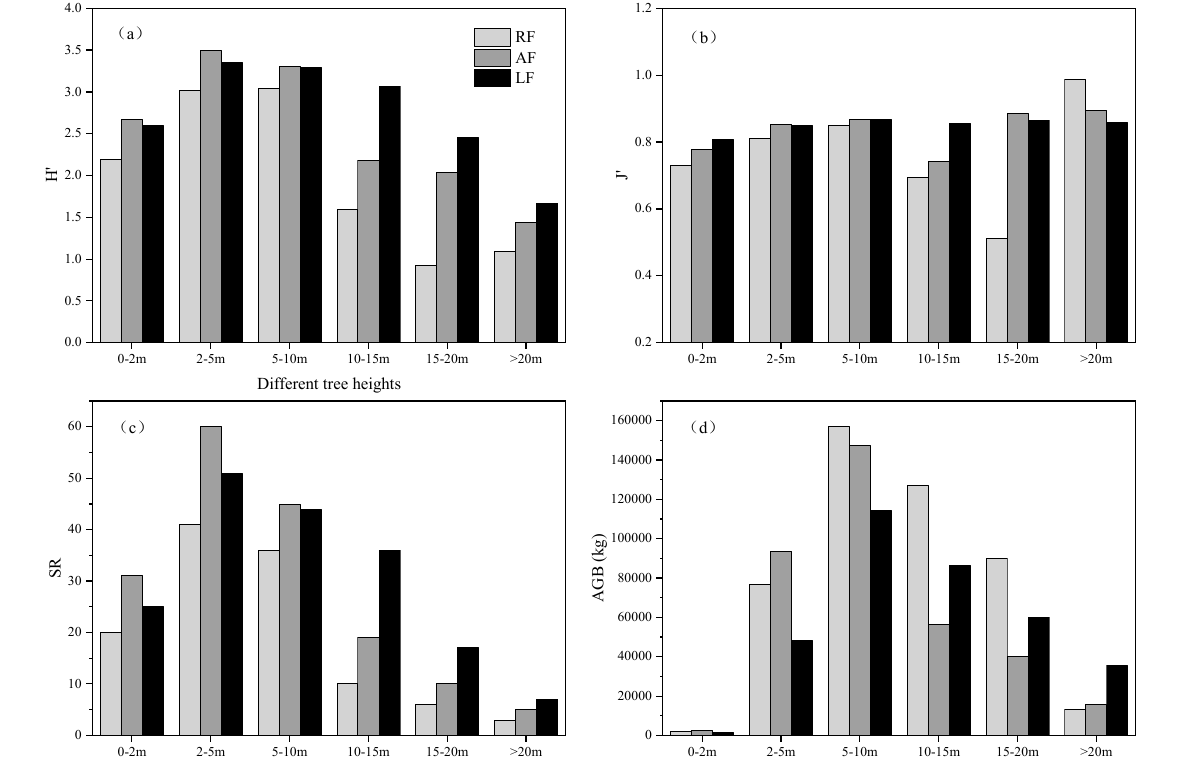
Figure 5. Distribution attributes of species diversity indexes and above-ground biomass at different height grade. ( a ) depicts the magnitude of Shannon–Wiener index (H’) at tree height grades for different forest types; ( b ) depicts the magnitude of evenness index (J’) at tree height grades for different forest types; ( c ) depicts the magnitude of species richness (SR) at tree height grades for different forest types; ( d ) depicts the magnitude of above-ground biomass (AGB) at tree height grades for different forest types. RF, road forest; AF, attached forest; LF, landscape and relaxation forest.